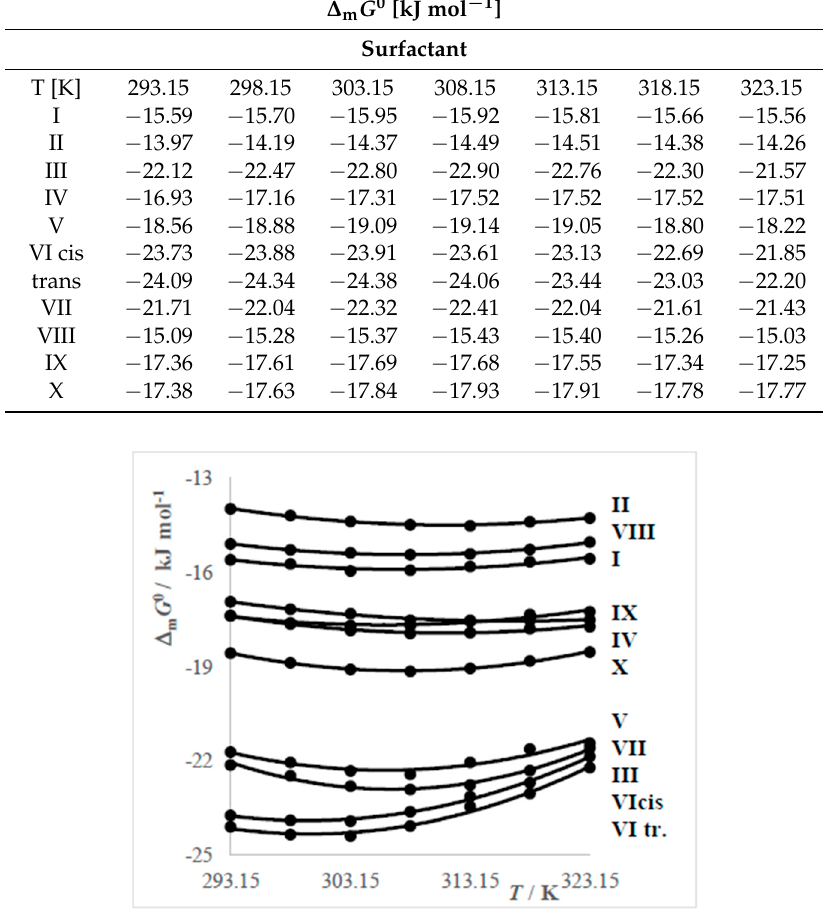
Figure 7. Dependences of Δ m G 0 = f ( T ) of surfactants in solution.